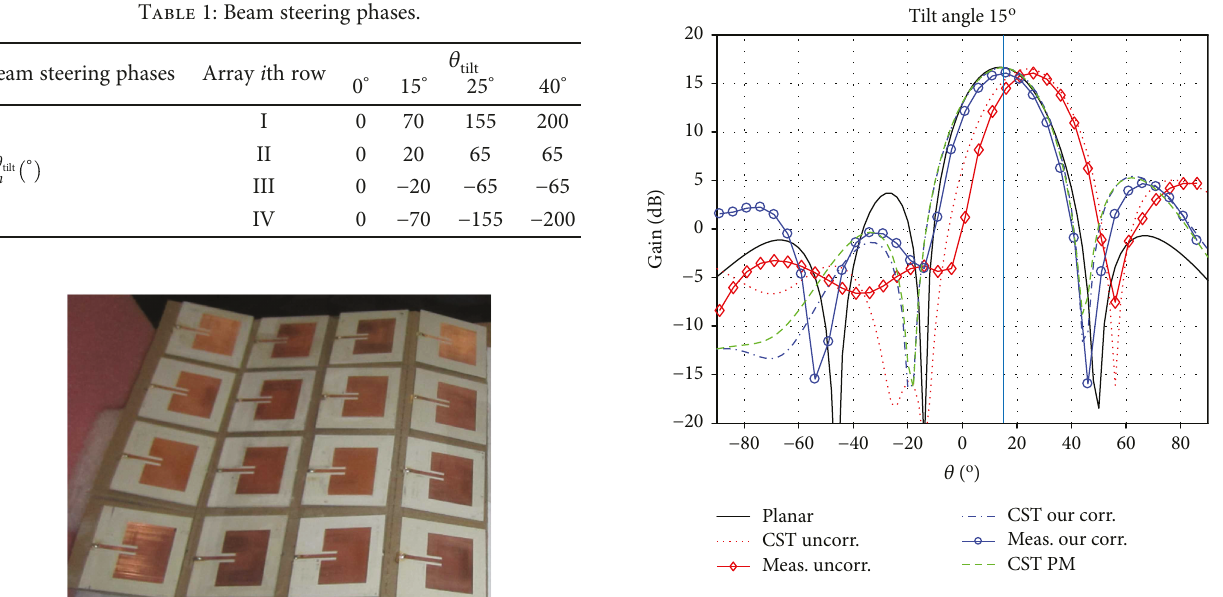
Figure 5: Simulated and measured 4 × 4 antenna gain: planar, uncorrected, corrected with our approach, and corrected with the projection method patterns on the yz -plane for θ